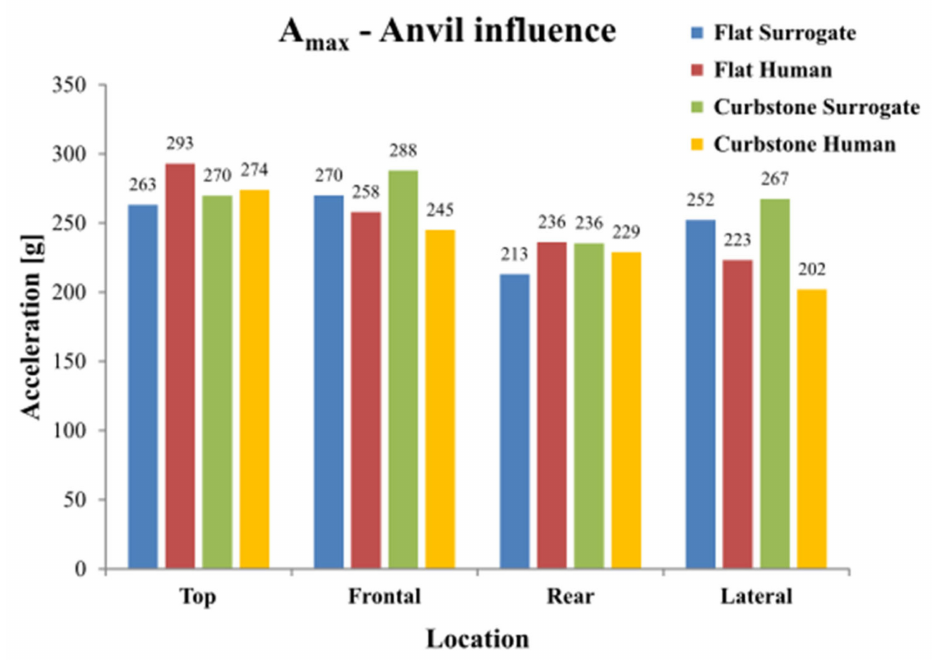
Figure 12. Comparison between two head models used at 4.4 m / s for di ff erent anvil’s